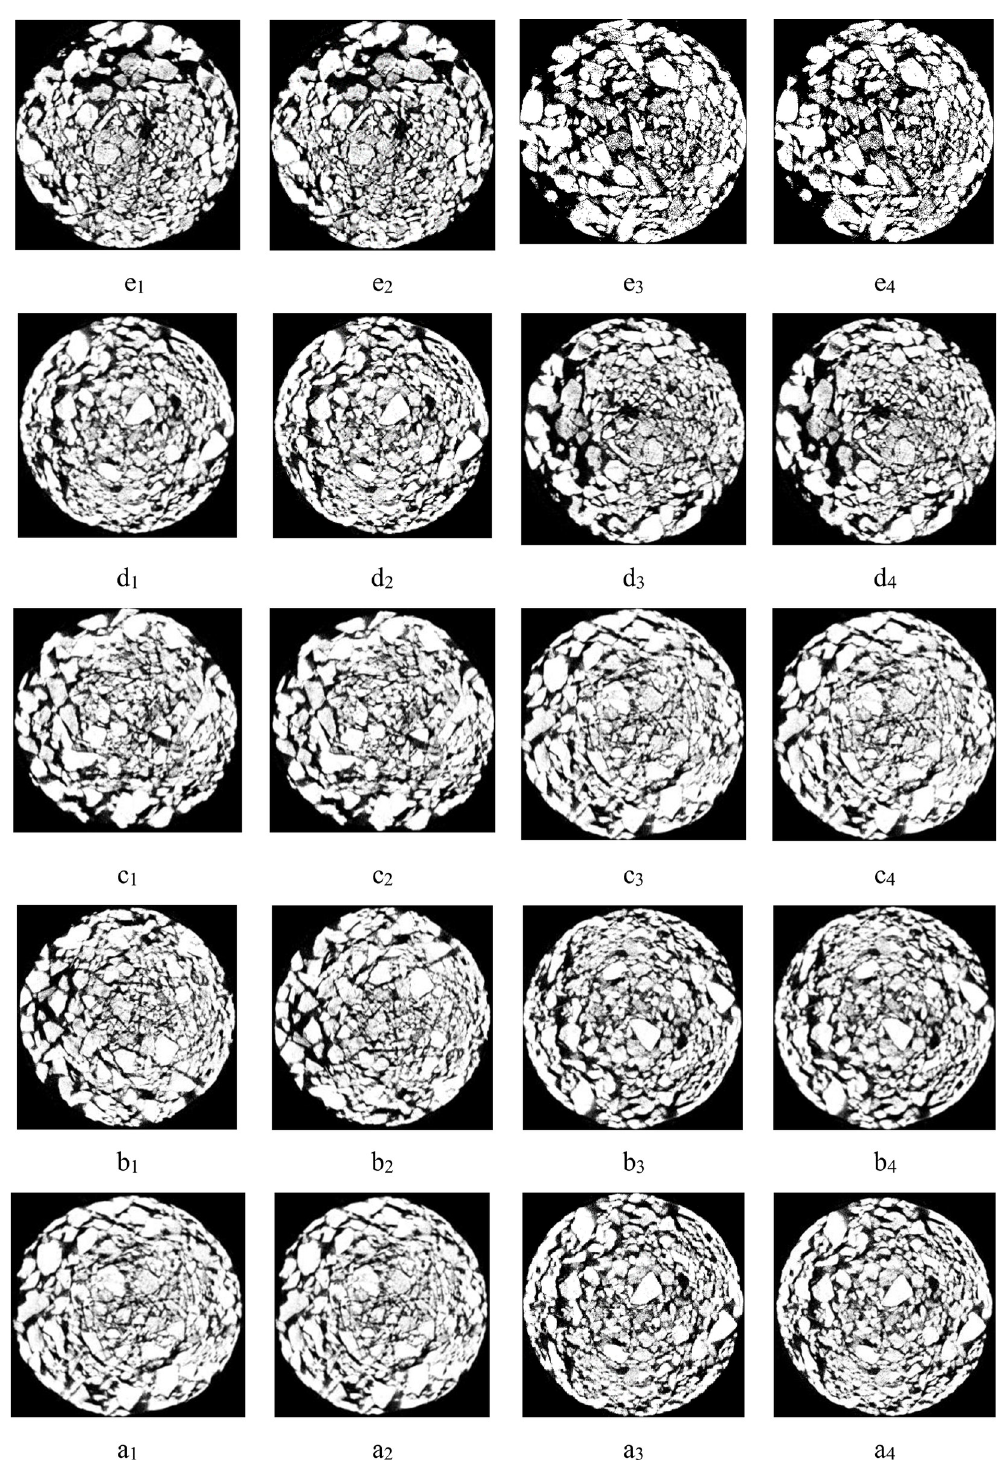
Fig 5. Sample structures of groups A and B before and after